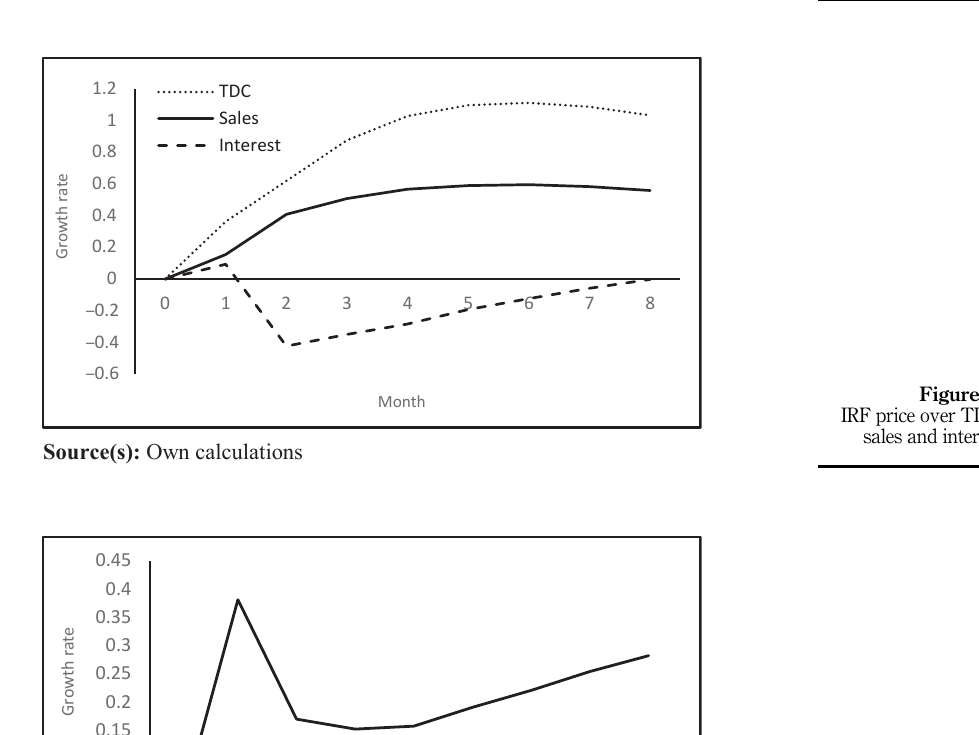
Figure 7. IRF operating cost and interest over investment